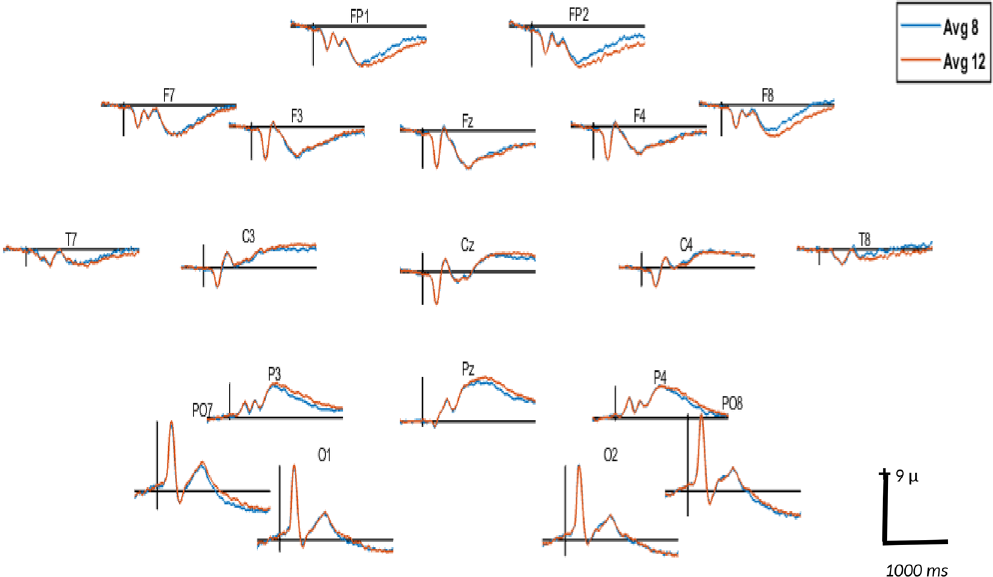
Figure 7. Grand averaged signal in 19 selected channels for 8 and 12 dot displays. Time window: − 200– 1000 ms. Positivity is plotted